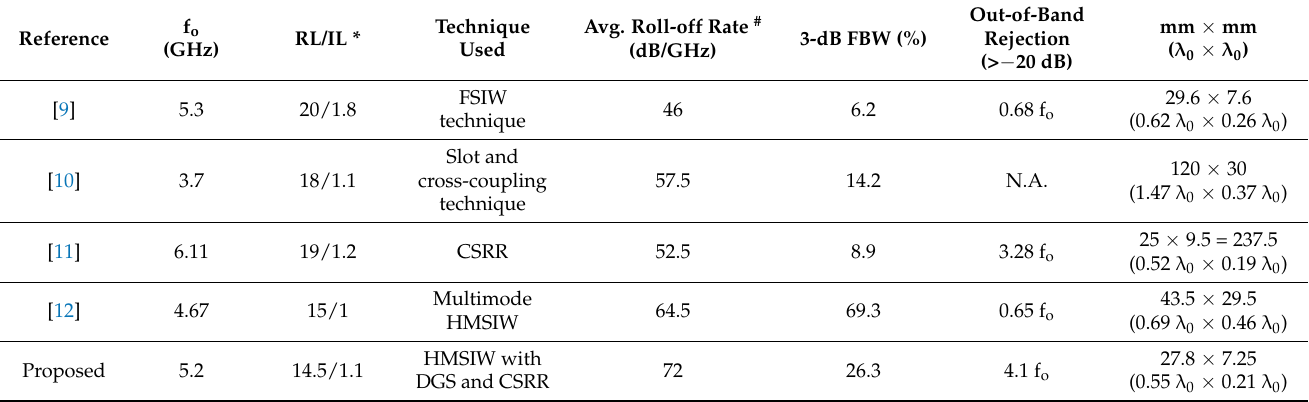
Table 1. Evaluation of performance with recently reported SIW BPFs for sub-6GHz 5G